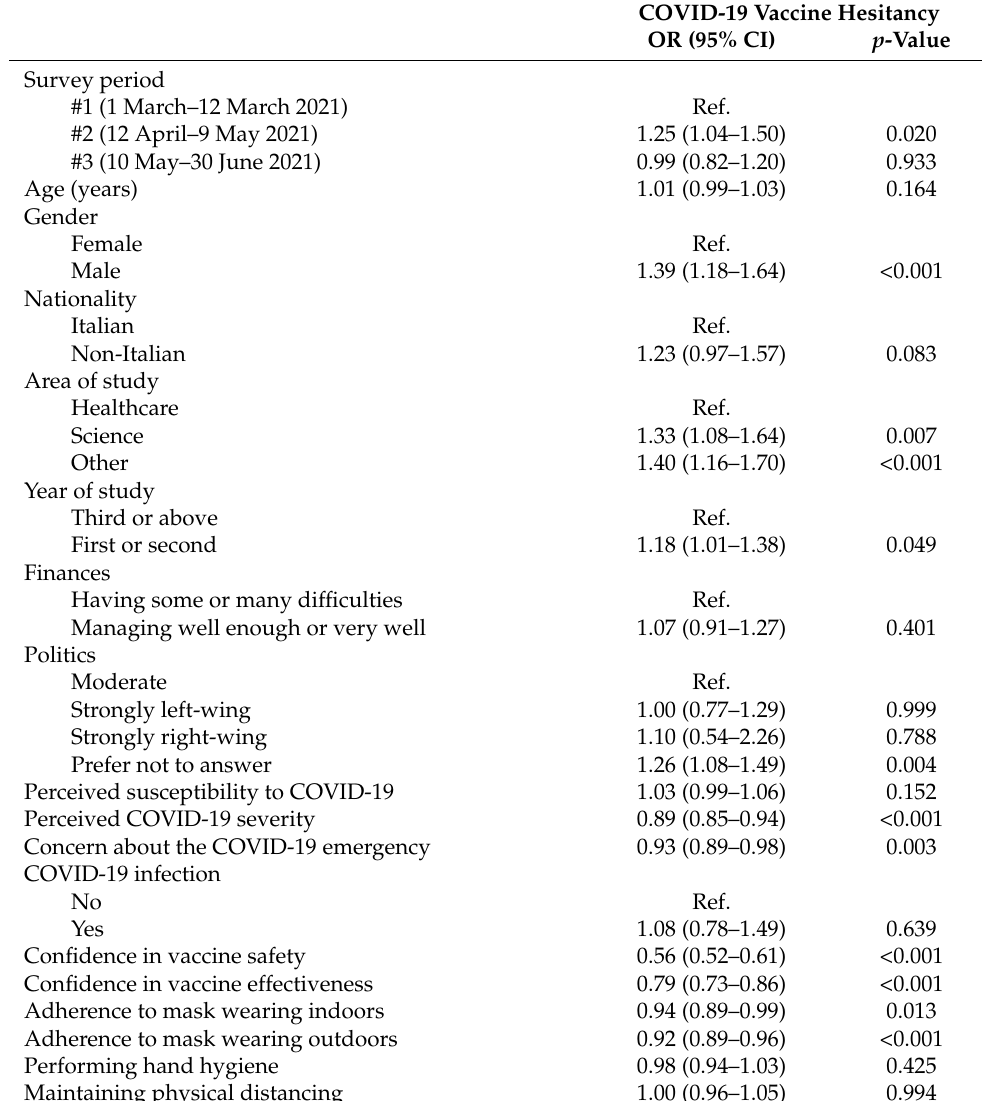
Table 4. Multivariable logistic regression model for COVID-19 vaccine hesitancy among the students surveyed between 1 March and 30 June 2021, Sapienza University of